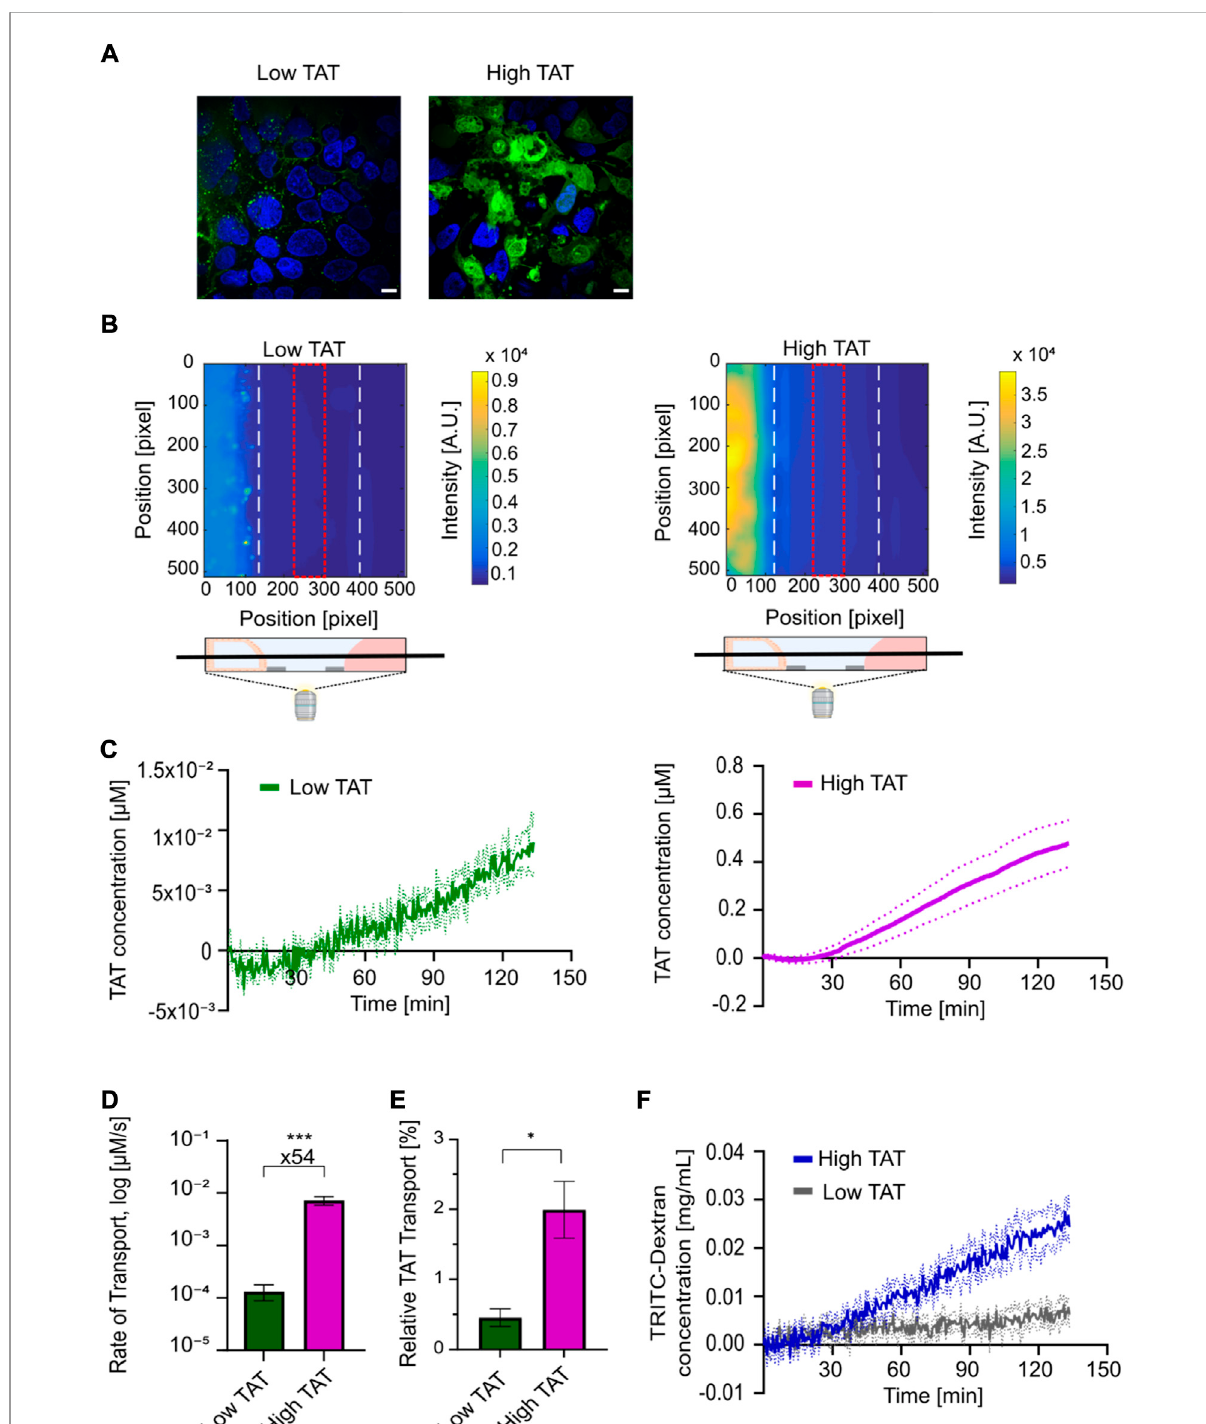
FIGURE 6 Livecell imaging-baseduptakeandtransportquanti fi cationofTAT for determininghigh-temporal resolution kinetic transport pro fi lesreveals a strong concentrationdependentTAT transport incoculture tubules. (A) Livecell micrographs depicting TAT(green) and Hoechst(blue) intensities in coculture tubules treated with (left) low concentration of TAT (2 µM) or (right) high concentrations of TAT (24 µM). Scale bar is 10 µm. (B) Representative fl uorescence surface intensity plot after 130 min incubation with the low TAT (left) and high TAT (right) concentrations. The surfaceintensity plots aretakenfromtime seriesacquiredusinghigh-temporalresolutionlive cellimagingofTATtransport.The fi eldofviewwasset as a z-plane in the middle of each chip-system, including all three connected channels as depicted. The fl uorescence intensity summed along the